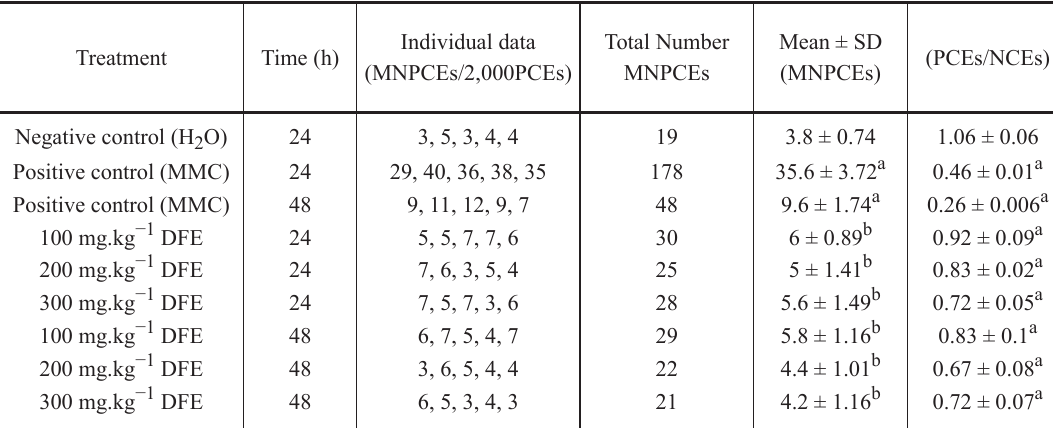
MNPCE frequencies and PCE/NCE ratio after treatment of the animals using different doses of Duguetia furfuracea lyophilized leaf extract and